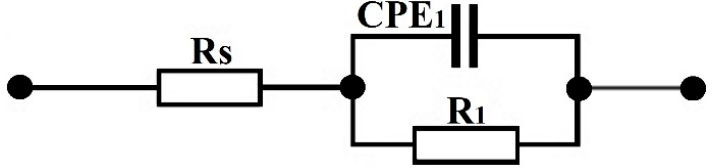
Figure 3. Electrochemical equivalent circuit: R s —solution resistance between the specimen and the reference electrode, R 1 —charge transfer resistance, CPE 1 —double layer capacitance.